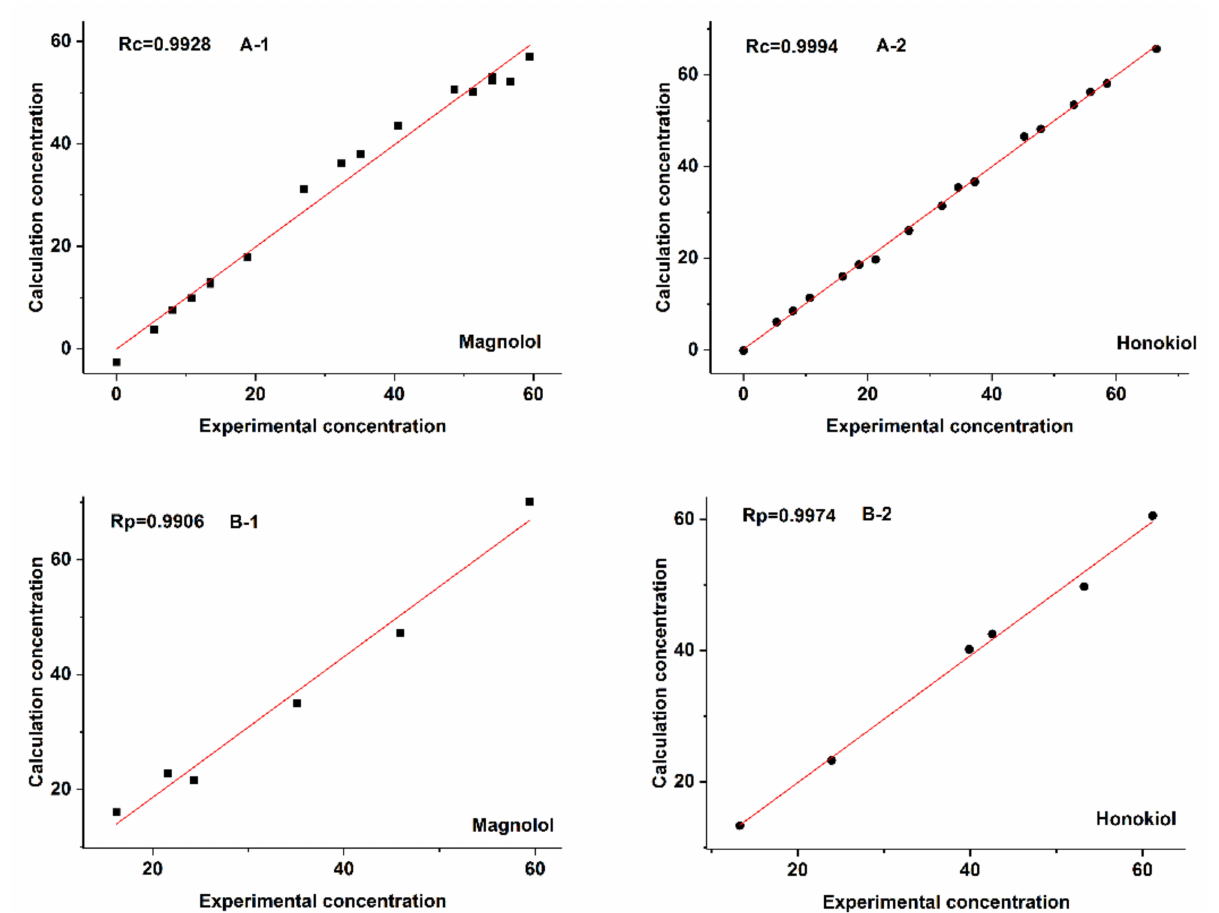
Figure 7. Plot of the experimental concentration against the calculation concentration obtained from the N-PLS method on the basis of the new constructed 3D EEM spectra for Data Set 2. A-1 and A-2 are the correlation coefficient of calibration ( R c ) for magnolol and honokiol, respectively. B-1 and B-2 are the correlation coefficient of prediction ( R p ) for magnolol and honokiol,